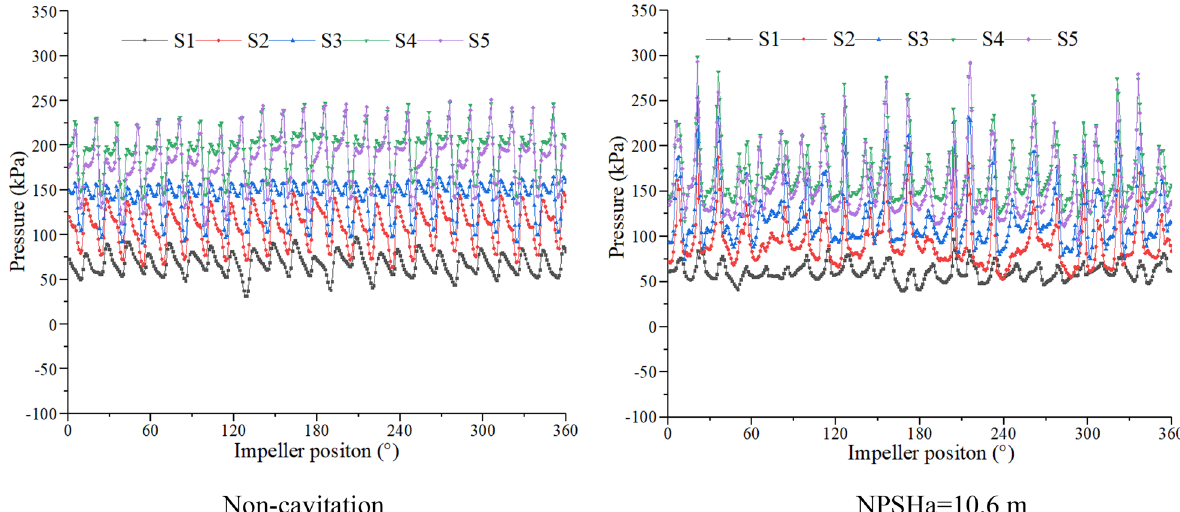
Figure 15 Pressure fluctuations in the side channel pump with time